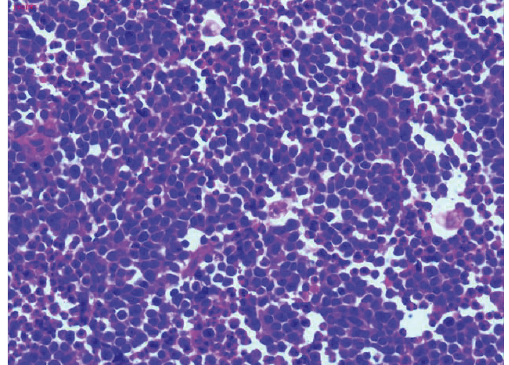
Figure 2: Histology of the cervical small cell carcinoma (X200). There was hypercellularity and scanty stroma. The cells were arranged in ribbons, lines, or waves, which are typical of small cell carcinomas.